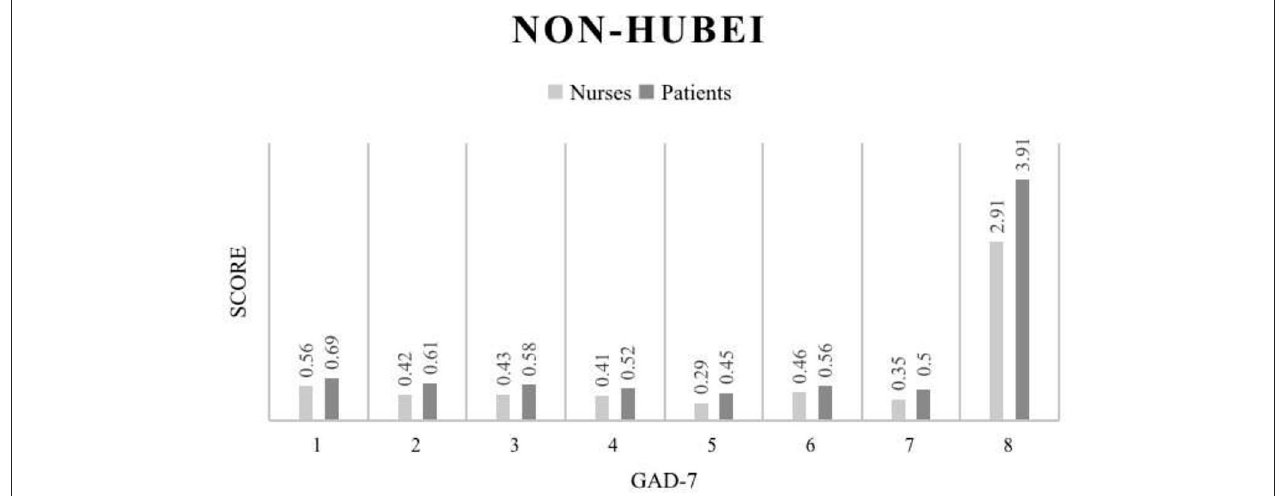
FIGURE 4 | GAD-7 score results for the Non-Hubei region.